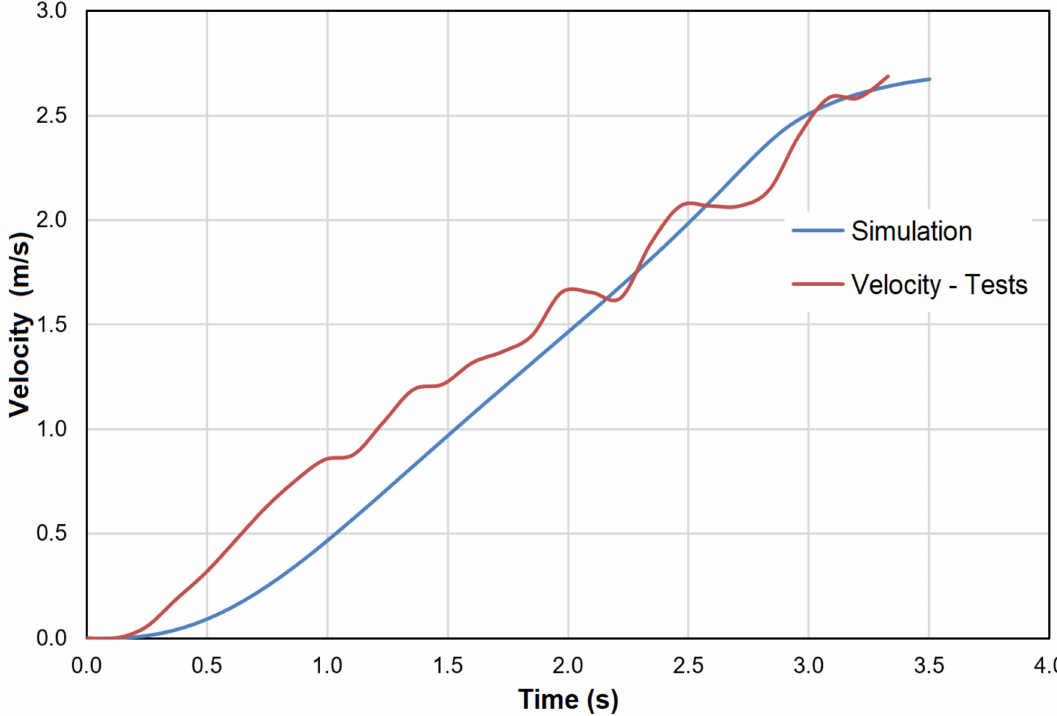
Figure 17. Comparison of velocity measurement results, and analysis of the results for the value of the working stroke s = 6